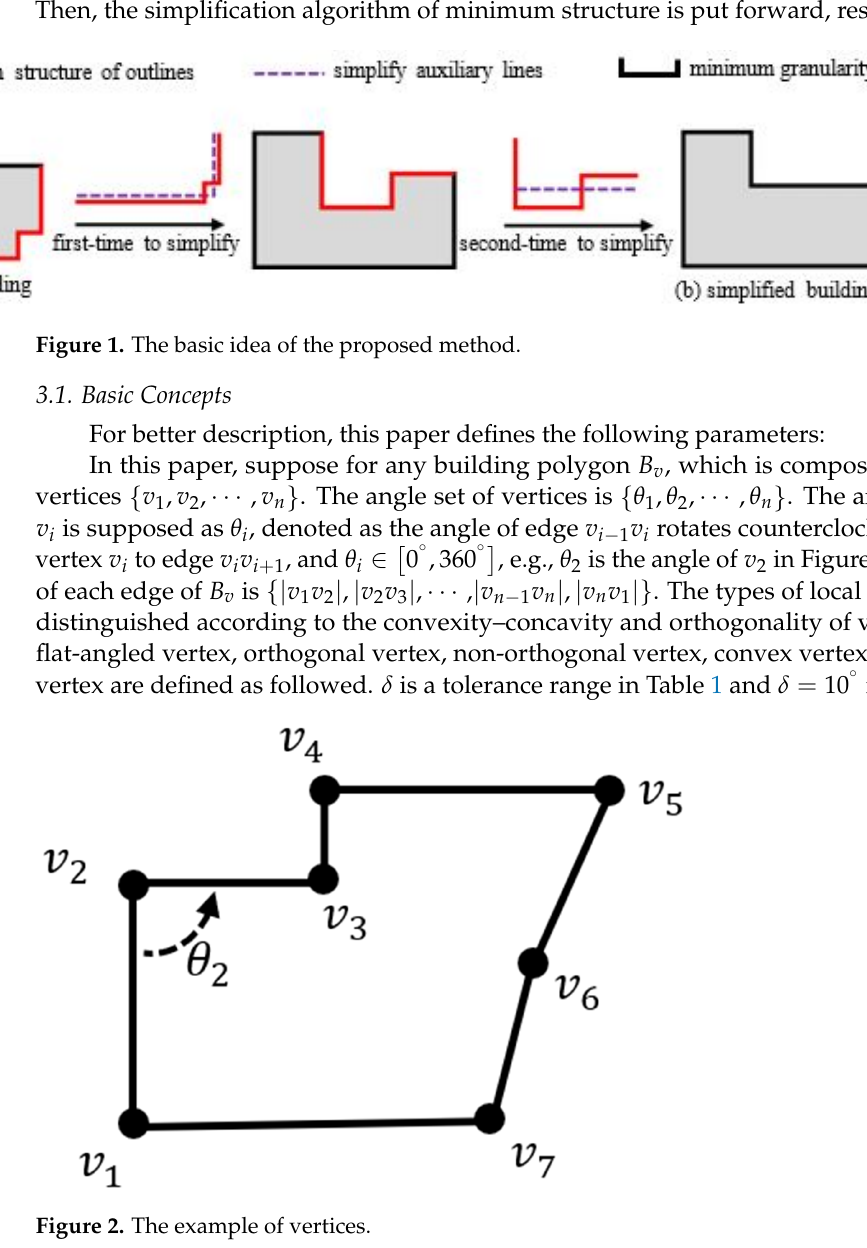
Figure 2. The example of vertices.